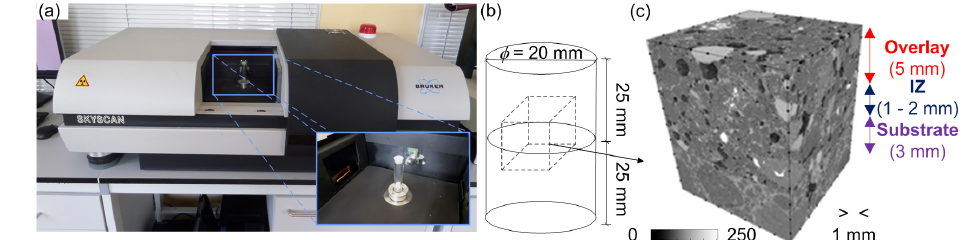
Figure 2. View of ( a ) the X ‐ ray micro ‐ CT (micro ‐ computed tomography) with a sample placed on a tripod; ( b ) the scheme of the sample element prepared for tests using the micro ‐ CT method; ( c ) a fragment of the 3D image of a microstructure subjected to further analysis.